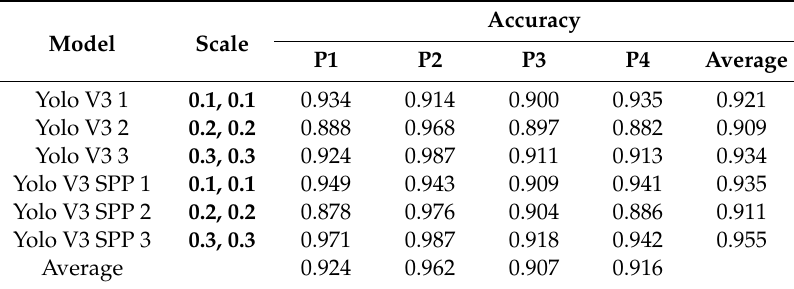
Table 3. Testing accuracy for all classes.